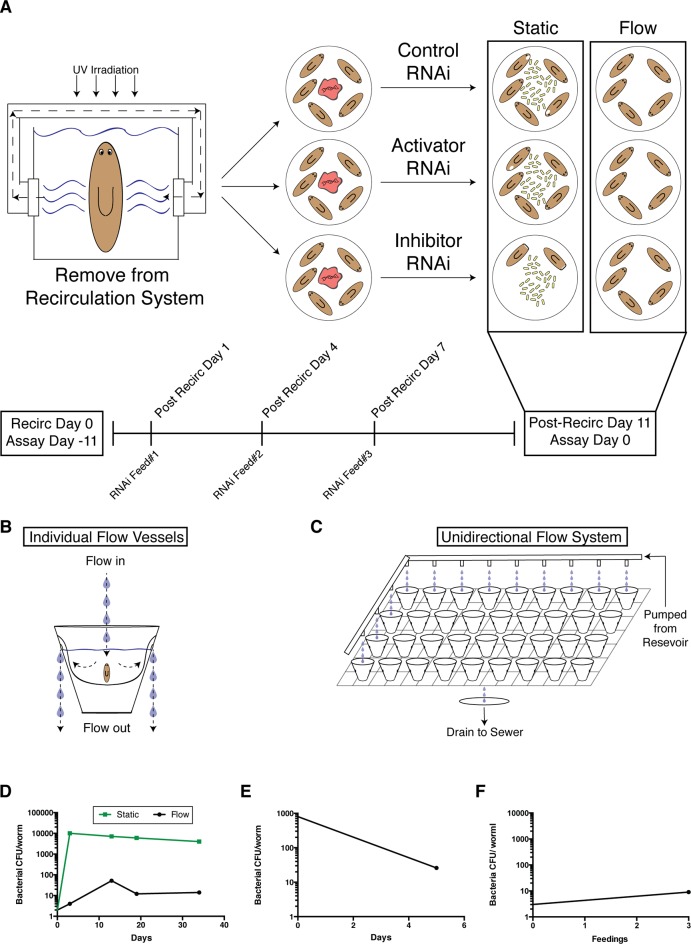
A novel flow culture method for planarian RNAi in low septic conditions.(A) Diagram depicting comparison of worm health following execution of the RNAi protocol in static versus flow culture. Worms removed from recirculation culture and placed in static culture experience a robust amplification of bacterial levels and are susceptible to lesion formation. RNAi of components that normally inhibit lesion formation or bacterial infection would exacerbate this effect. In comparison, maintenance of worms in a flow culture system can maintain the healthy, low septic state independent of RNAi manipulation. Diagram of (B) individual planarian flow culture vessels and (C) an integrated unidirectional flow system (planaria water is administered to all cups but depicted only in the left column and the upper row to simplify visualization). (D) Comparison of bacterial CFU/worm during culture in static versus flow RNAi conditions following exit from recirculation culture. (E) Effects of flow culture on bacterial CFU of worms with pre-existing heightened bacterial levels. (F) Bacterial CFU/worm prior to and after 3 RNAi feedings in the flow culture system (experiment independently repeated > 3 times). Bacterial CFUs were determined from samples of 4 pooled worms per timepoint.